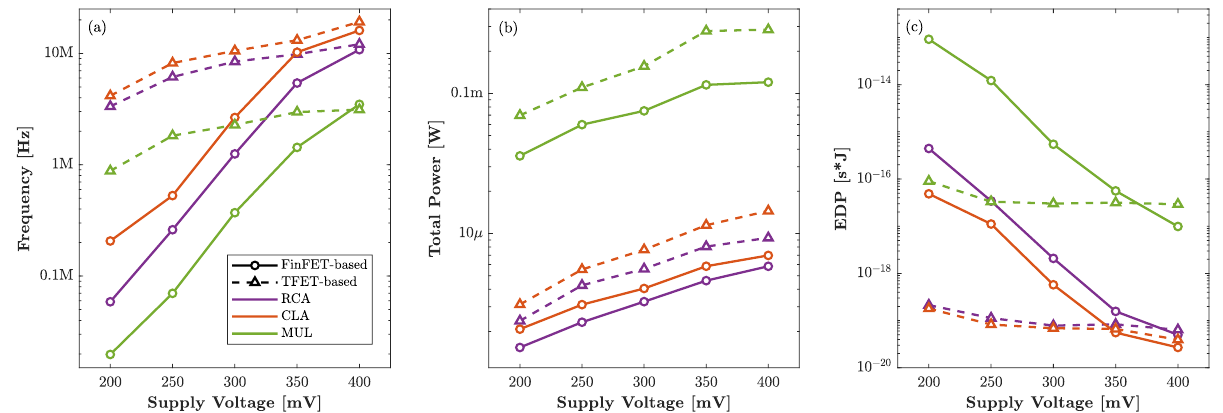
Figure 8. ( a ) Maximum frequency of operation, ( b ) total power consumption, and ( c ) EDP of a 64-bit Ripple-Carry Adder (RCA), a 64-bit Carry Look-Ahead Adder (CLA), and a 32-bit multiplier (MUL) based on TFET and FinFET devices across a supply voltage range of 200 mV to 400 mV.